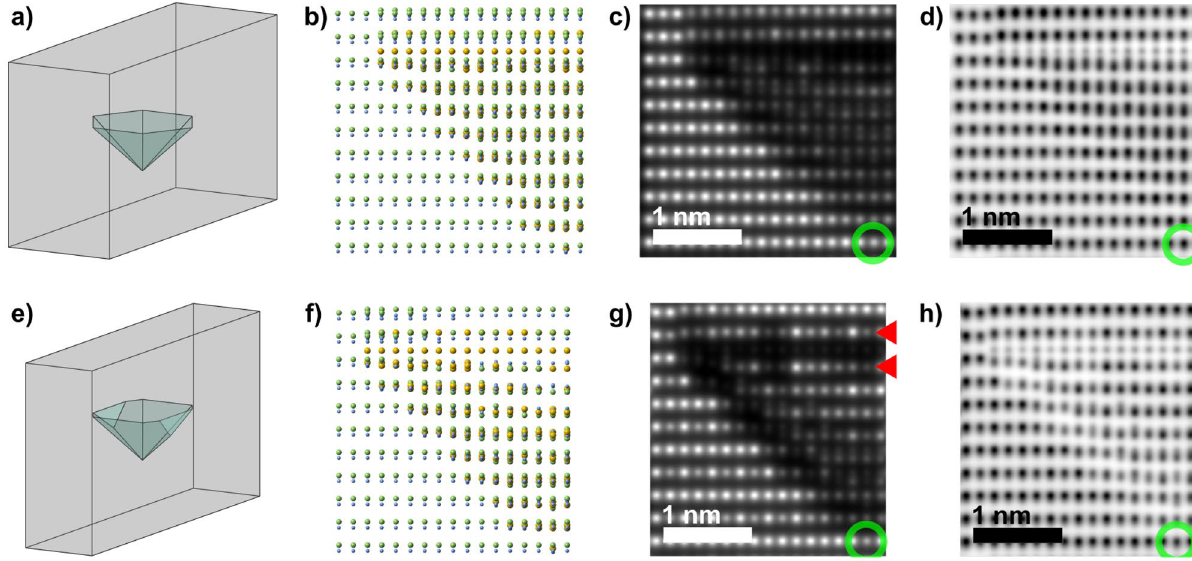
Figure 5. Schematic structure and simulated STEM images of the PID structures in the < 1 ¯ 100 > projection for different thicknesses. ( a ) and ( e ) show schematic lamellas of different thicknesses embedding and partly embedding the defect, respectively. ( b ) and ( f ) show the corresponding projected atomic structure model of half the PID, including the apex at the bottom right. ( c ) and ( g ) show the simulated HAADF-STEM images while ( d ) and ( h ) show the corresponding ABF-STEM images for the different thicknesses respectively. The green circles and red arrows identify the apex and the planes adjacent to the Mg-layer, respectively. In the model structure, Ga is light green, N is light blue and Mg is atom for simplicity, generating a slightly shorter bond length (Mg-N) in this layer compared to the Ga-N bond length in the rest of the structure. The Mg-atoms in the model structure at the { 0001 } facet are 6-fold coordinated (corresponding to the calcula- tion by Northrup 23 ) while those in the inclined inversion layer exhibit 3-fold coordination. This 3-fold coordina- tion is the most likely arrangement considering the inversion of the tetragonal coordination of Ga/Mg moving from matrix into the PID. At the inversion layer, seen in Fig. 3b, the intense atoms shift downwards, suggesting a flattened coordination with the N-atoms, hence a local 3-fold coordination occurs at this layer. Example simulations of the modified PID structure embedded in matrix lamellas with different slab thick- nesses are shown for the < 1 ¯ 100 > projection in Fig. 5a–d versus e–h (the < 11 ¯ 20 > projection is shown in Fig. S3, Supplementary Information online). Schematic drawings of the simulated lamella thickness in relation to the PID are shown in Fig. 5a and e, where Fig. 5a shows a fully embedded PID with continuous overlap between PID and ambient matrix in projection. In Fig. 5e the lamella surfaces truncate the PID, hence the lamella exhibit regions without overlap between matrix and PID. Fig. 5b and f show the projected structures for the respective thickness. Fig. 5c,d and g,h show the corresponding simulated HAADF- and ABF-STEM images. These simula- tions correspond well with the acquired images in Fig. 3, where the darker Mg-based { 0001 } facet is clearly seen in both Fig. 5c and g. Qualitatively, the intensity of the layers adjacent to the Mg-layer (indicated by red arrows in Figs. 3 and 5) is lower than the ambient matrix, which infers that Mg randomly substitutes for Ga in these layers. Both in the acquired and in simulated images, the atomic columns exhibit intensity fluctuations, sup- porting the random substitution of Ga with Mg within these layers. Within Fig. 5g the fluctuation is significant, deriving from the thin simulated structure (less than 7 nm), in which single atoms in projection relatively affect the contrast more strongly. The experimentally observed lattice shift within the PID is reproduced in the simulated images, support- ing the modified model. At the inclined interfaces, the intensity reduction originates from the presence of Mg. However, the thickness of the sample affects the visibility of the inclined facets substantially, compared to the top { 0001 } facet. While the simulation in Fig. 5g shows the near ideal case, the region near the apex still projects a significant overlap with the embedding matrix. Image contrast and lattice shift become blurred and are not visible near the apex, even for the thinnest sample. This is also reflected in Fig. 3b, where the inclined facets compare well with the simulations in terms of shift and intensity loss. Overall, the simulated and acquired images match qualitatively, and verify the adapted model. It is also found that the image contrast, associated with the defect, strongly depends on sample tilt. Fig. 6 shows a PID where dark regions clearly outline the shape. Image simulations of the improved model match the dark outline well if a tilt around a horizontal axis in the structure’s projection is considered. The exact tilt angle is not attempted to be matched, but the fact that the contrast appears when tilting the simulation confirms the assumption of tilt in the acquired image. Accordingly, the acquired image in Fig. 6 is a fingerprint that further support the three Mg-atoms wide inversion layer outlining the pyramid’s { 11 ¯ 23 } facets. For simplicity, the simu- lated structure had full occupancy of Mg instead of the predicted 3 4 22 , but this difference is only expected to slightly